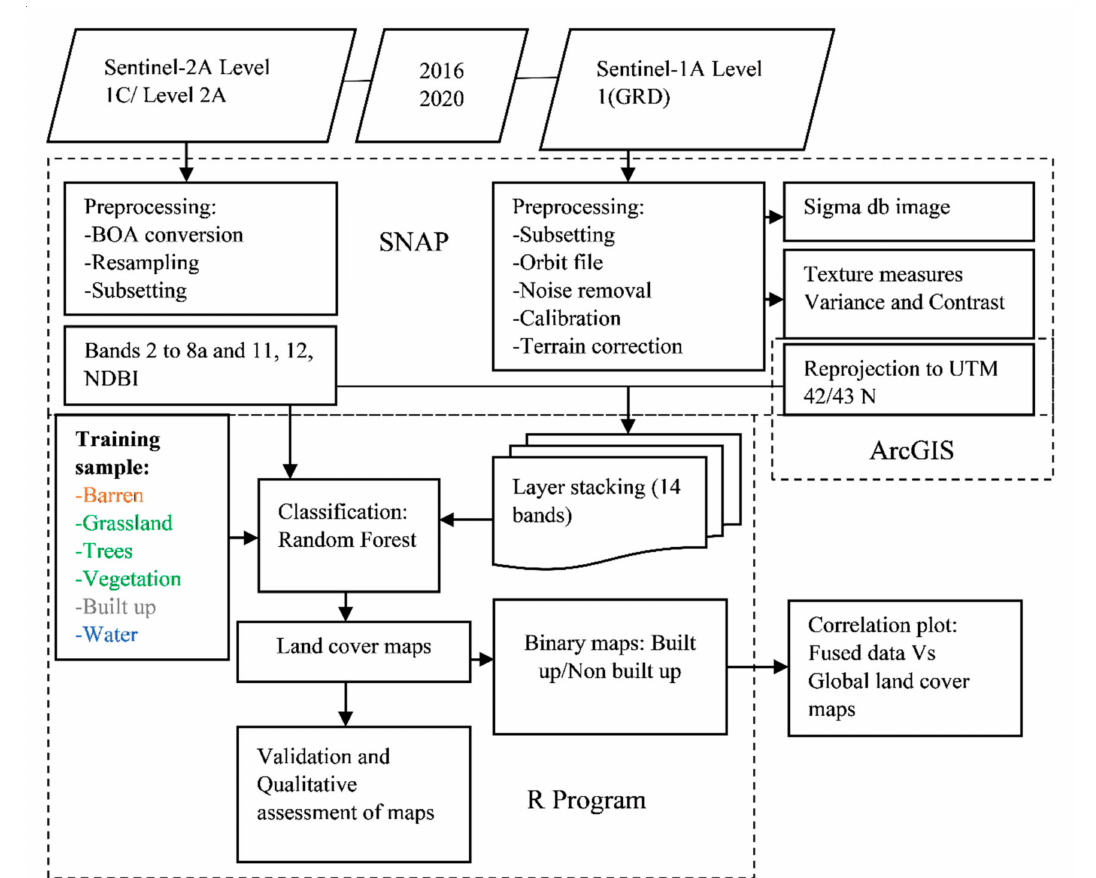
Figure 2. Detailed methodology flowchart for fusion of S-1 and S-2 data and land cover classification utilizing random forest.